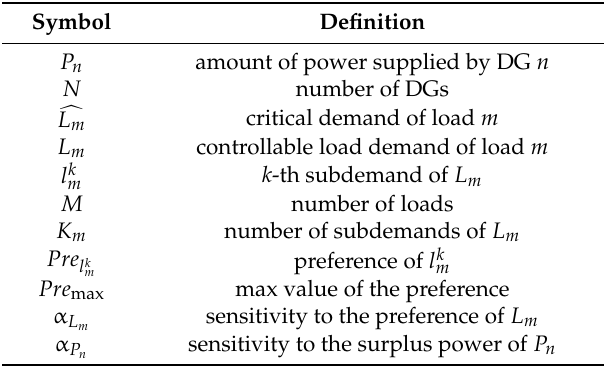
Table 1. Summary of important symbols. DG: distributed